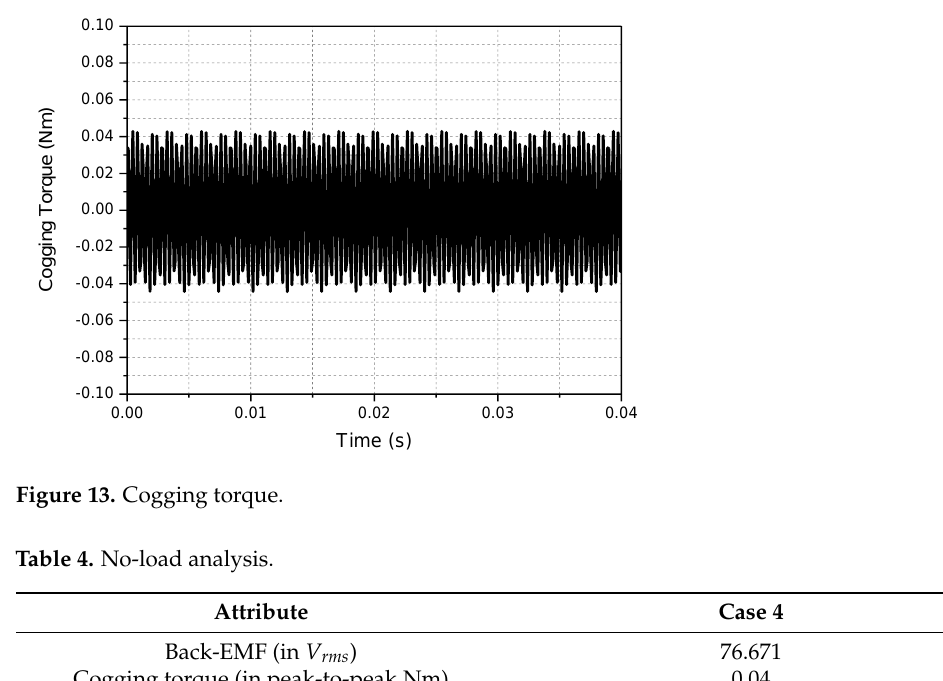
Figure 12. ( a ) Back-EMF of the employed machine and ( b ) its FFT plot.